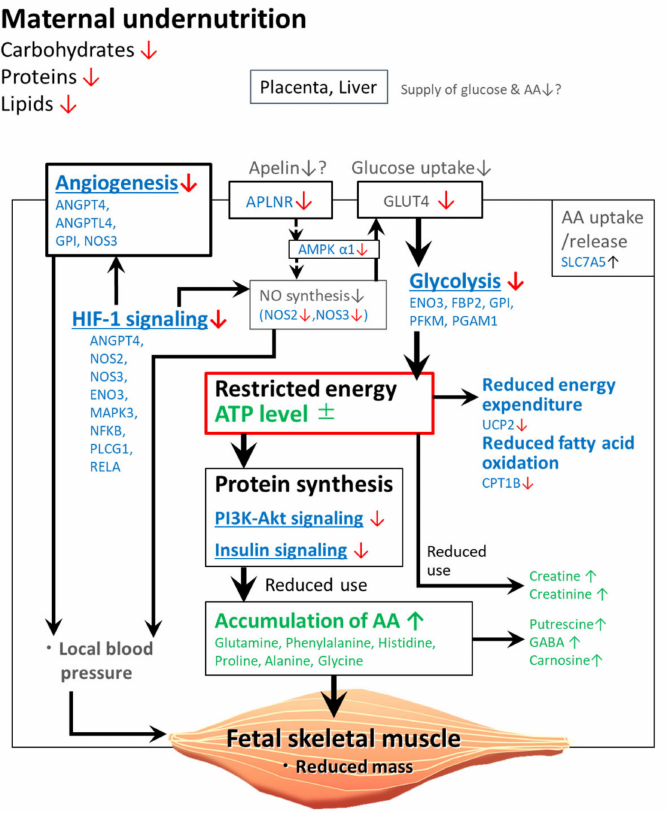
Figure 4. Hypothetic scheme of influences of maternal nutrient restriction on the fetal skeletal muscle molecular pathways and metabolisms. Genes and metabolites are shown in blue and green, respectively. Increase and decrease are indicated in small black and red arrows, respectively. Under- lined metabolisms/pathways are significantly extracted in GO/KEGG pathway analysis. Grayed events and metabolites were not determined in this study, but some of these were confirmed in previous